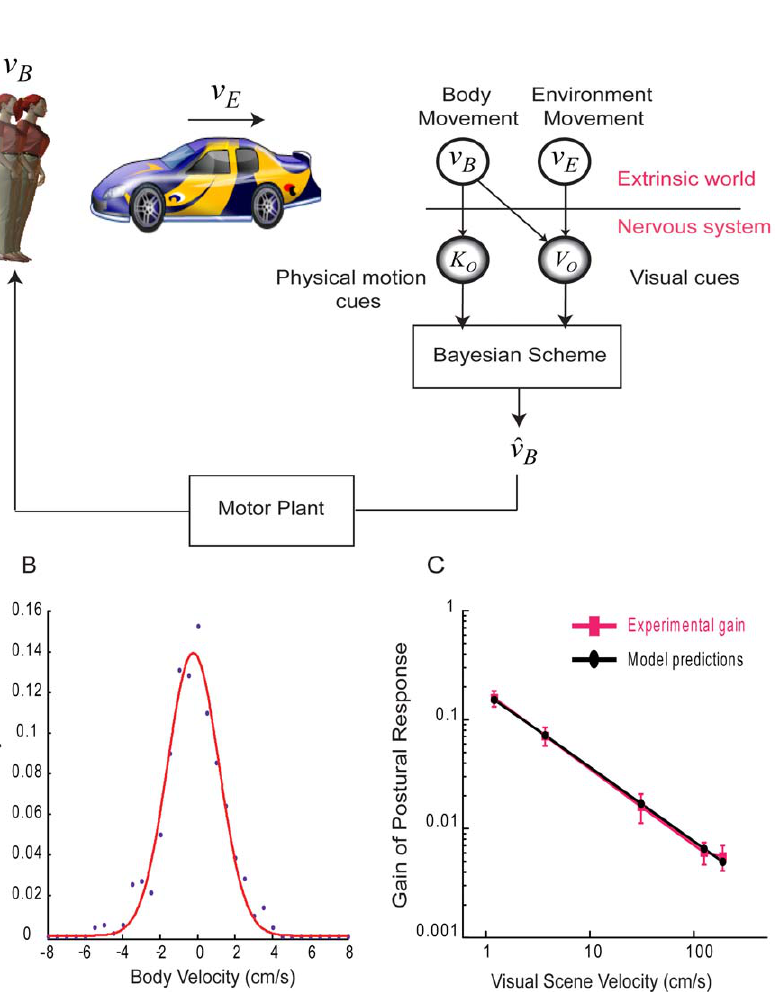
Figure 1. Sensory ambiguity influences postural behavior. (A) Graphical model, a compact way of describing the assumptions made by a Bayesian model. v B is the velocity of body motion, while v E is the velocity of the environment motion. K O represents a noisy estimate of the body velocity that is sensed by kinesthetic and vestibular signals. V O represents the visually perceived velocity of the relative motion between the body and the environment. The attribution model estimates ^ vv B from these perceived cues. (B) Distribution of body velocities during unperturbed stance averaged across subjects tested in our experiment (C) Experimental data and model fits for healthy subjects tested in our experiment.